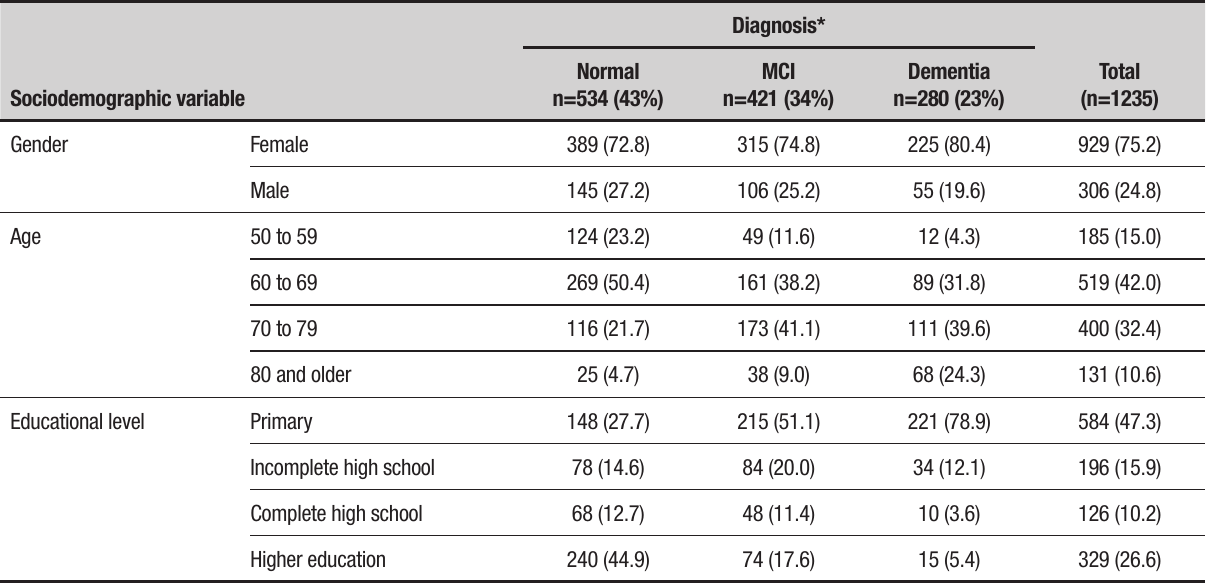
Table 2. Prevalence of MCI and dementia by gender, age and educational level in the 1,235 subjects.